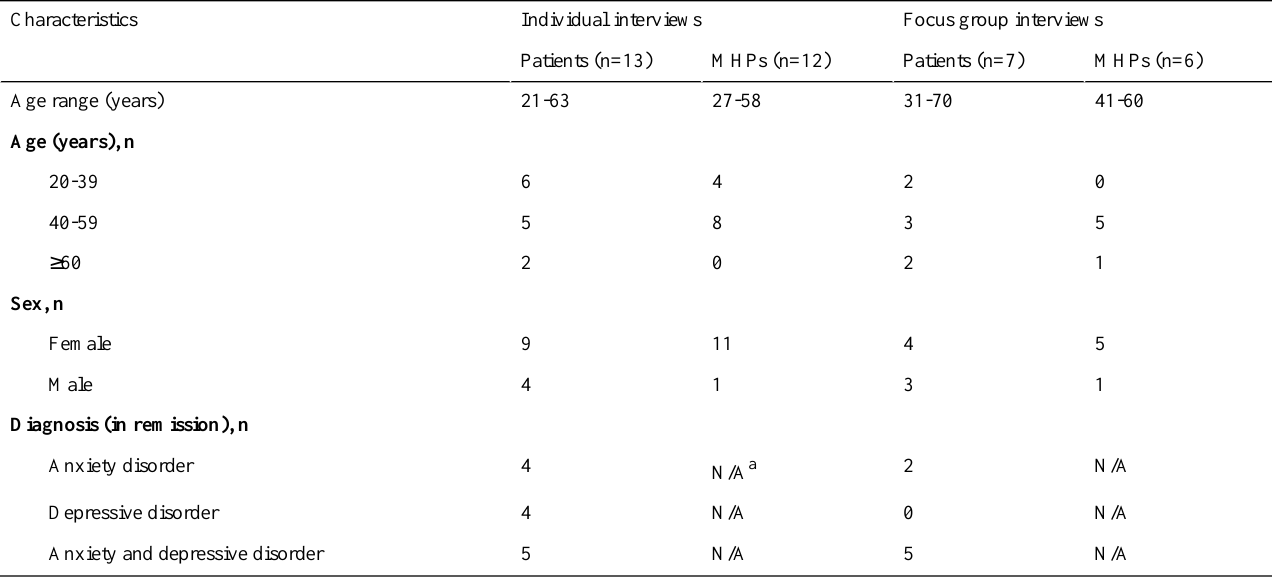
Table 1. Demographic and clinical characteristics of patients and mental health professionals (MHPs).